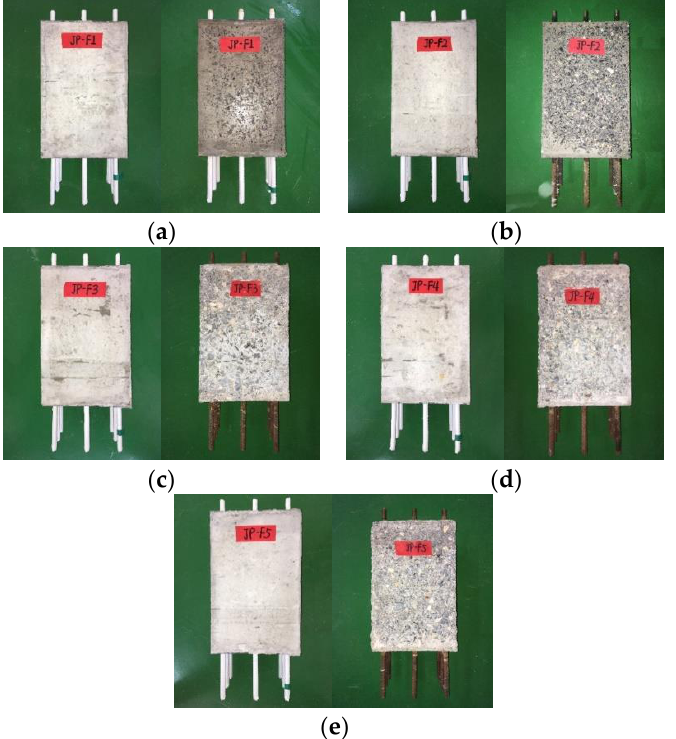
Figure 10. Experimental results of the rapid freeze – thaw cycles. ( a ) Comparison before and after 25 freeze – thaw cycles. ( b ) Comparison before and after 50 freeze – thaw cycles. ( c ) Comparison before and after 75 freeze – thaw cycles. ( d ) Comparison before and after 100 freeze – thaw cycles. ( e ) Comparison before and after 125 freeze – thaw cycles.